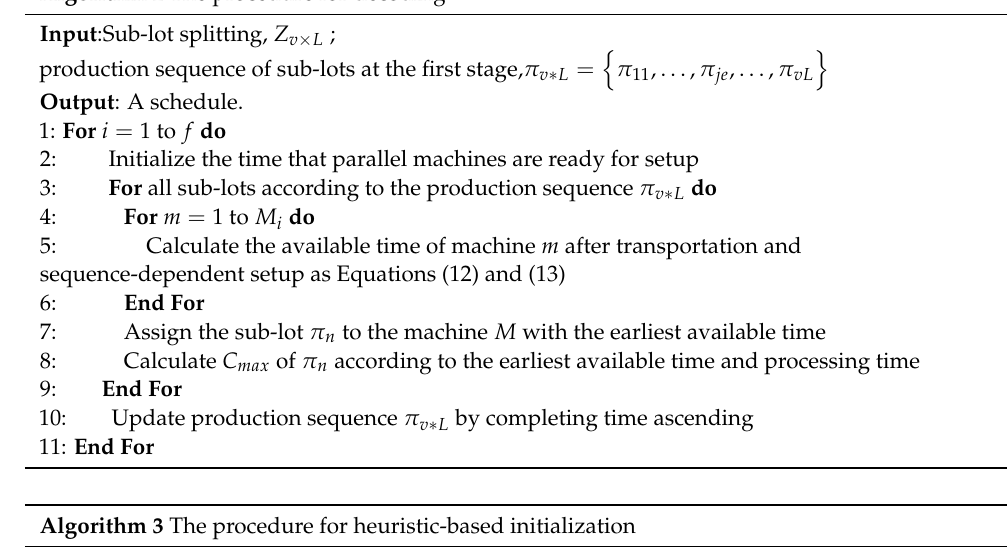
Algorithm 2 The procedure for decoding